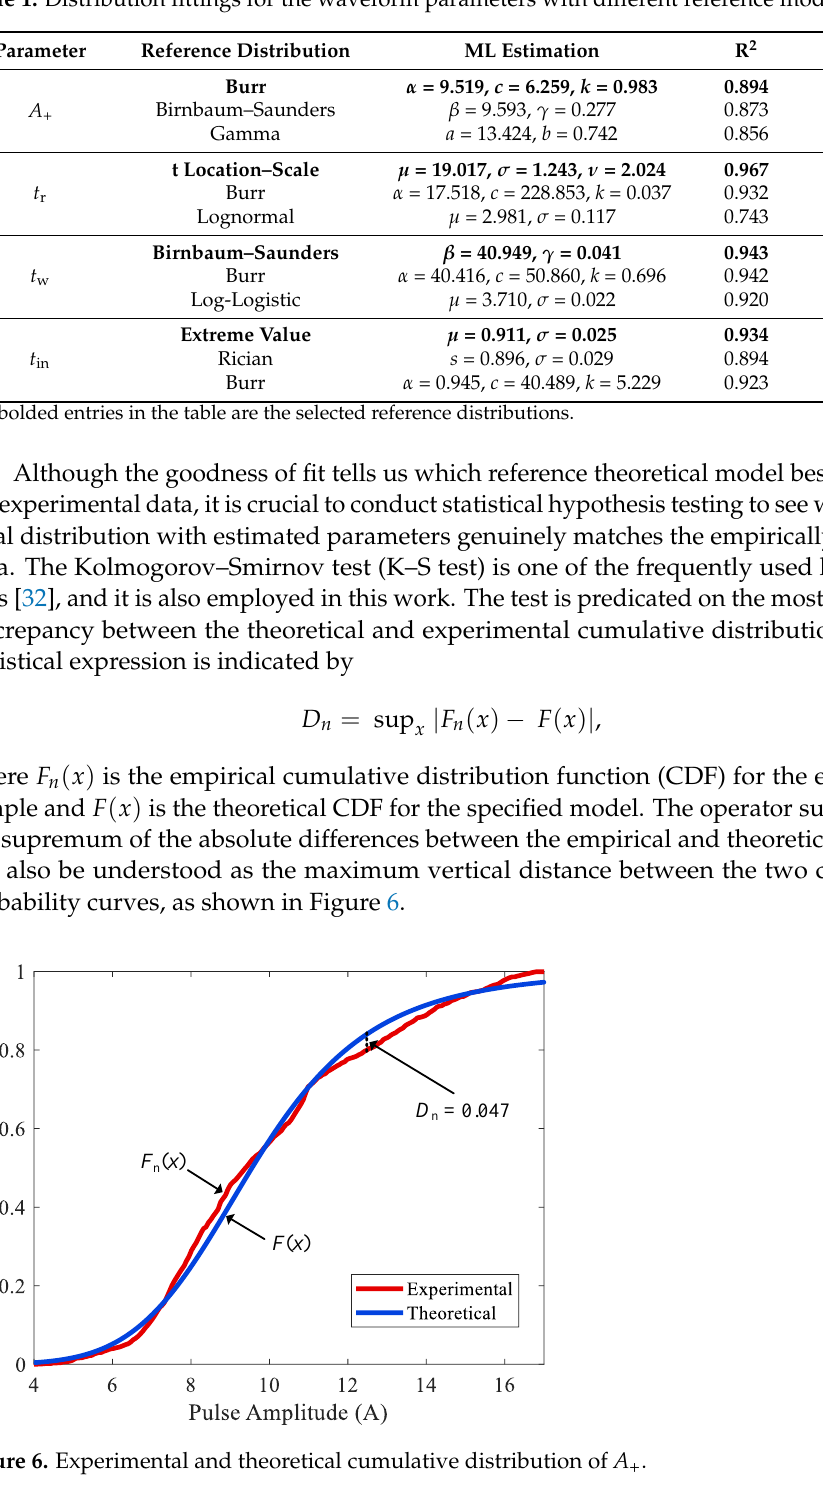
Table 1. Distribution fittings for the waveform parameters with different reference models.